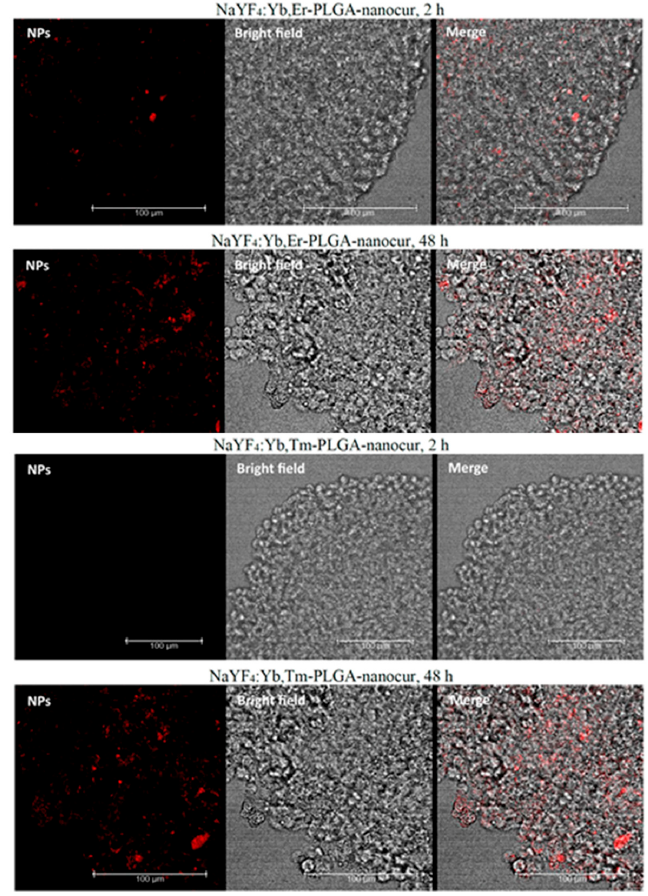
Figure 13. Micrographs of rat glioma C6 spheroids, 0.4 mg/mL UCNPs, 2 h and 48 h incubation, confocal fluorescent microscopy. The fluorescence of nanocurcumin is indicated in red, 488 nm excitation. Scale bar is 100 µ